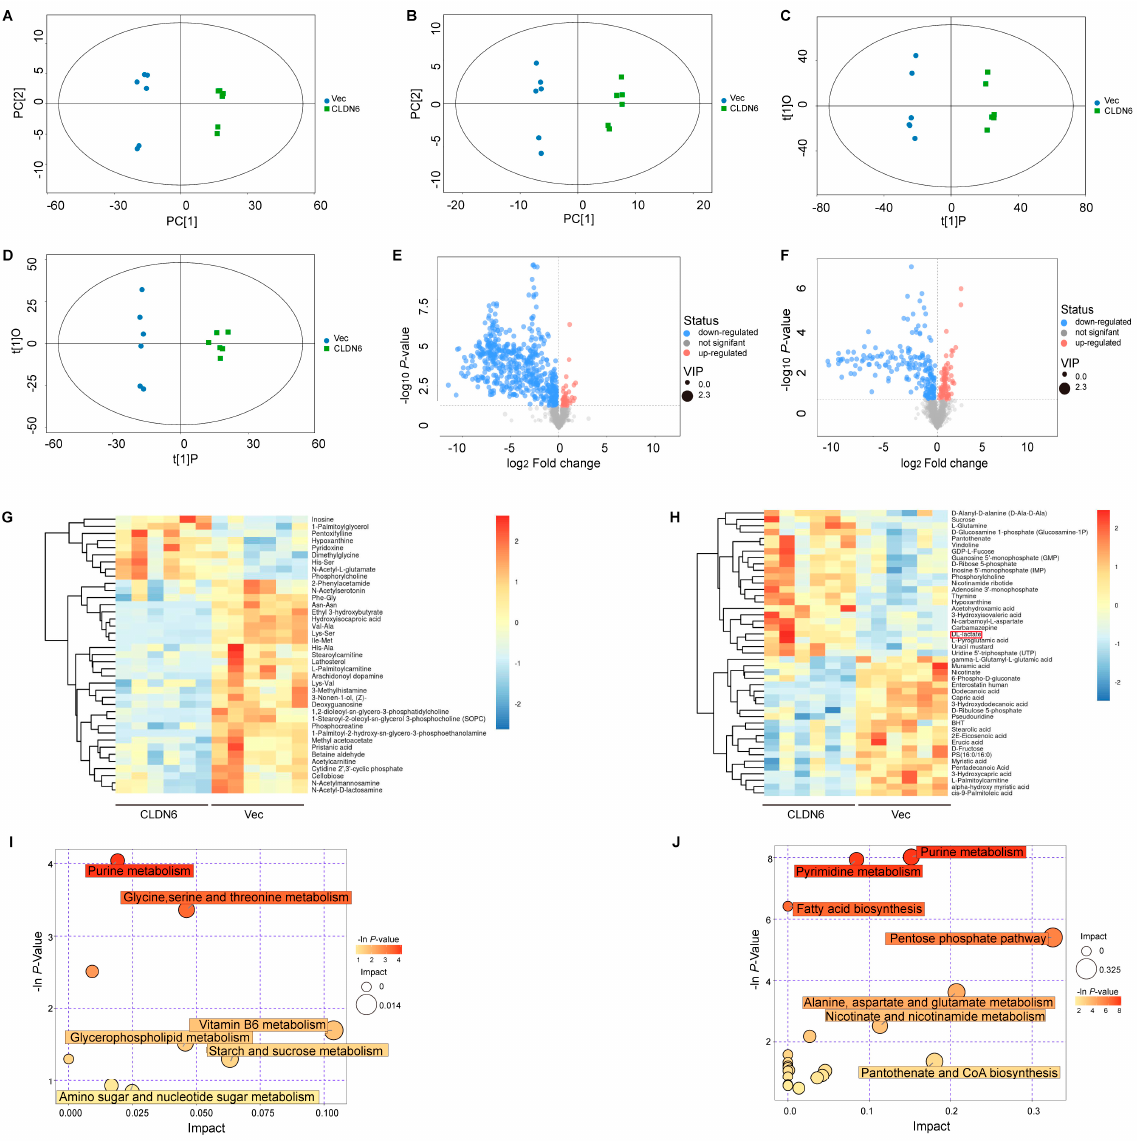
Figure 3. CLDN6 regulates the metabolism of MDA − MB − 231 cells. PCA and OPLS–DA plots generated from LC − MS/MS data of cellular metabolites in the positive ( A , C ) and negative ( B , D ) ion mode. ( E , F ) The volcano plot of differential metabolites between MDA − MB − 231/Vec and MDA − MB − 231/CLDN6 cells in the positive (left) and negative (right) ion mode. ( G , H ) Heatmap of hierarchical clustering analysis for group MDA − MB − 231/CLDN6 vs. MDA − MB − 231/Vec in the positive (left) and negative (right) ion mode. ( I , J ) Bubble chart of metabolic pathway analysis in the positive (left) and negative (right) ion mode. The color of the circle represents the p value, and the size represents the pathway impact